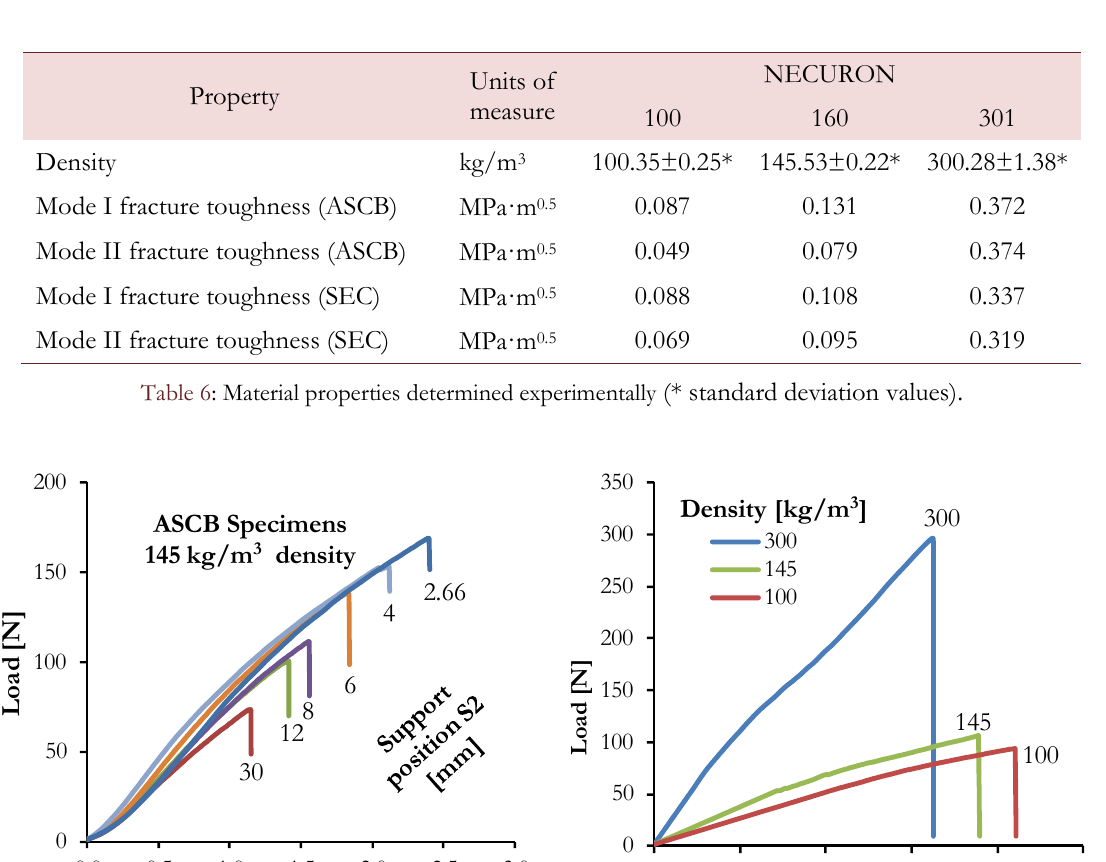
Figure 2: Experimental set - up with details of ASCB specimen in three point bending grips (top right), respectively with SEC specimen in Arcan grips (left and middle right).